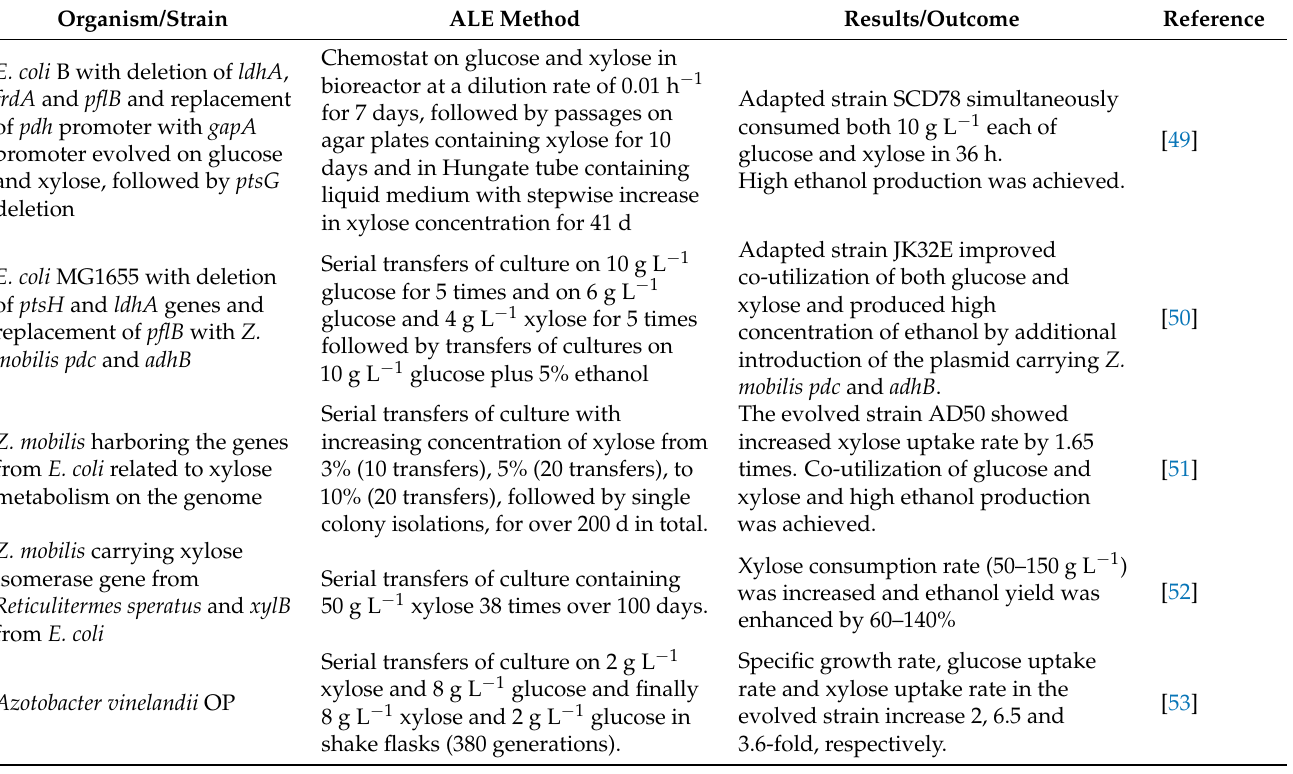
Table 2. Recent studies on ALE for improved xylose utilization by